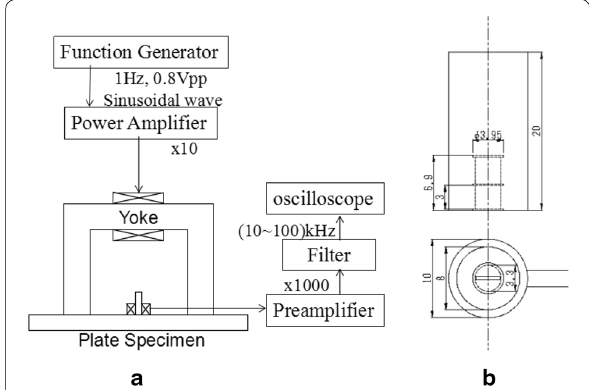
Figure 1 MBN experimental system: a schematic diagram of MBN experimental system, b design of the pickup coil